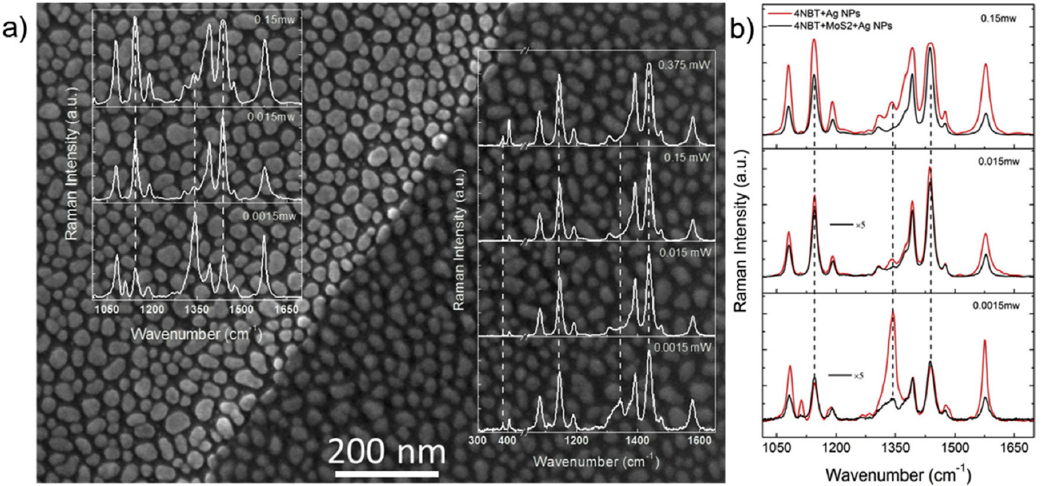
Figure 10. ( a ) The SEM of the Ag substrate, where the right regime is covered by MoS 2 , and the corresponding surface catalytic reactions in both regimes [111], ( b ) is the SERS spectra.